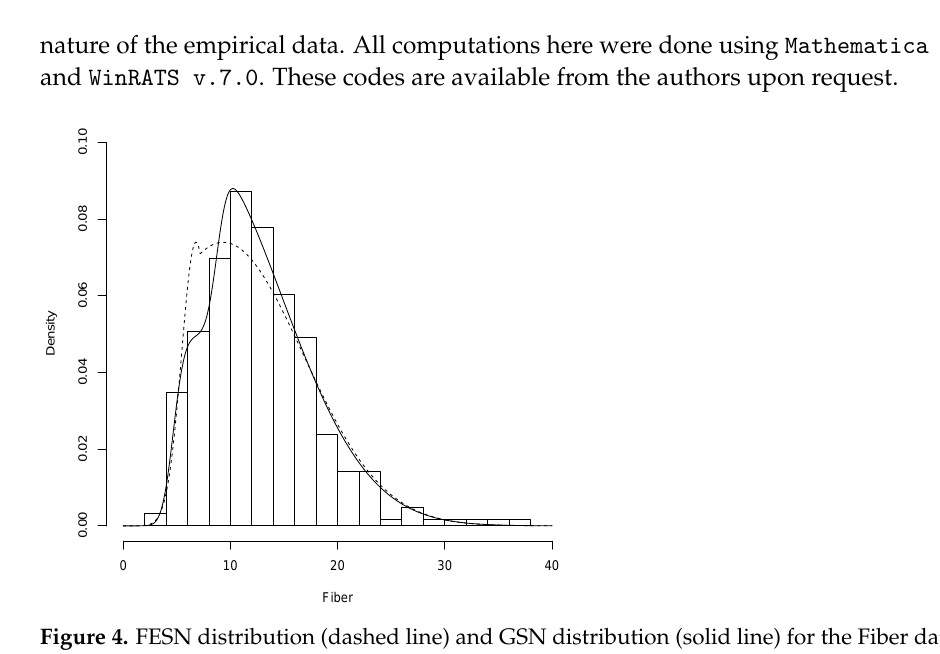
Figure 4. FESN distribution (dashed line) and GSN distribution (solid line) for the Fiber data.